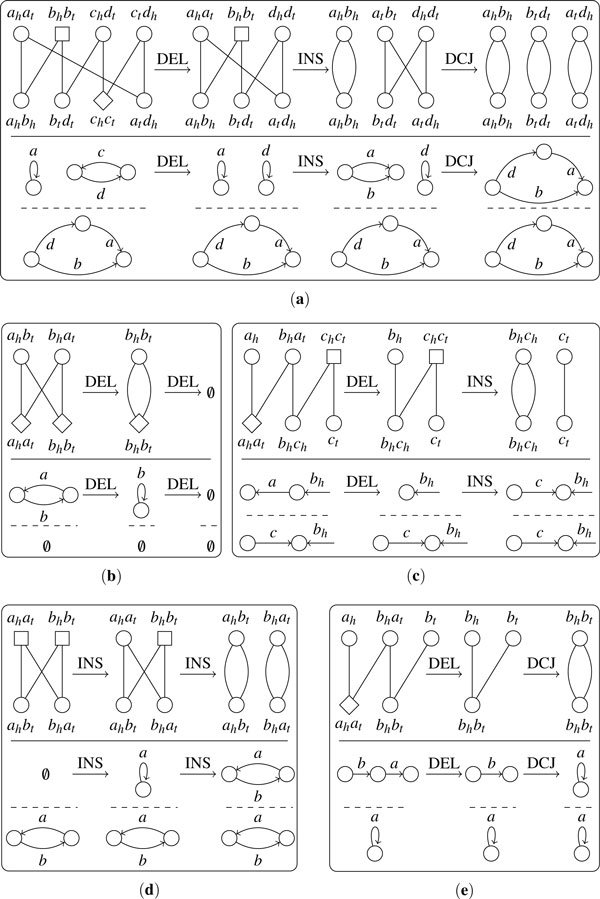
Examples of performing operations under the guidance of decomposition. In each subfigure, the above part shows the transformation of the adjacency graph; the below part shows the corresponding change in the genomic structure.